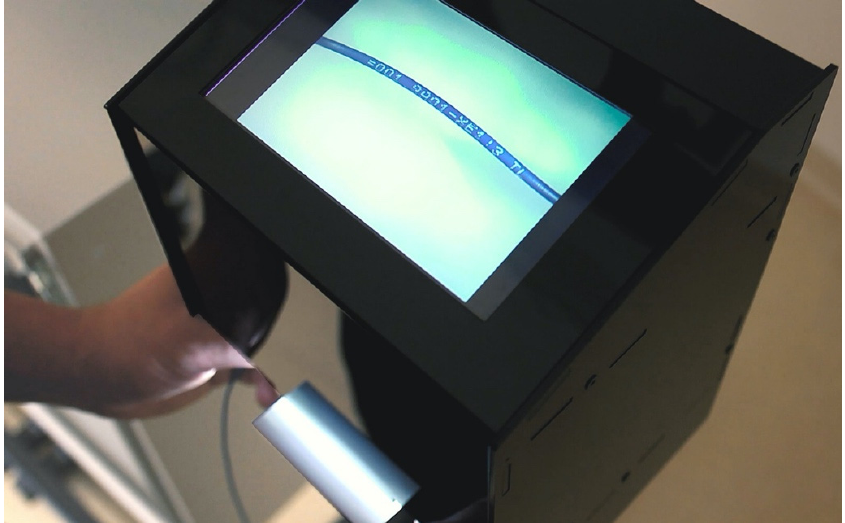
Figure 7. Wire reading with the WLR: the wire is placed by the operator on the image scene; the display on top shows the action in real time, which helps the operator to correctly place a wire.